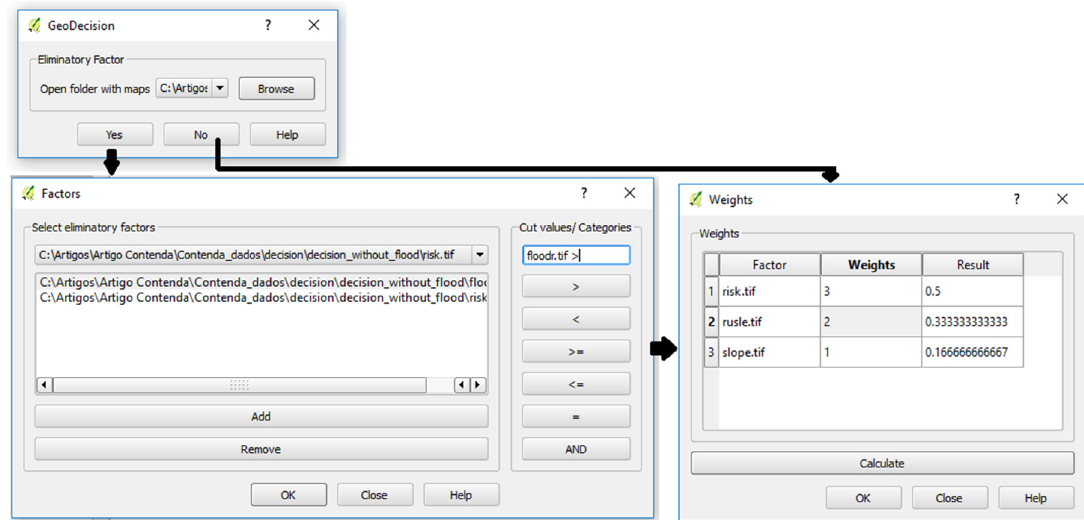
Figure 7. GeoDecision graphic interface (just for illustration purposes, the values presented are not the real ones).